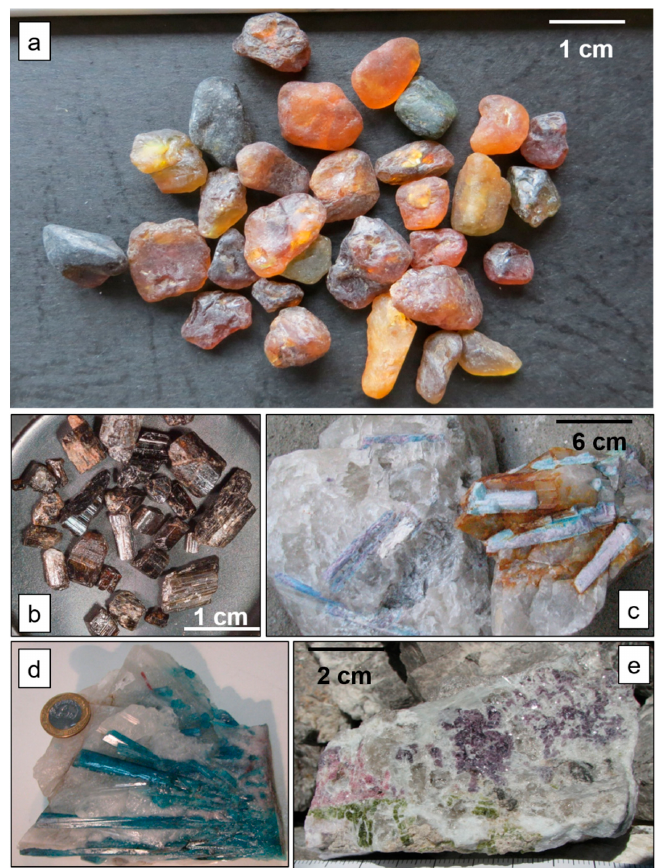
Figure 10. Tourmaline s.s.s. from placer and pegmatite deposits. ( a ) Panned concentrate for subrounded tourmaline from a fluvial placer in Tanzania. ( b ) Tourmaline concentrate from a colluvial placer SE Germany. ( c ) Pink and blue elbaite tourmaline laths in the Batalha Pegmatite, Brazil. ( d ) Paraiba tourmaline from the Capoeira Pegmatite, Brazil. ( e ) Pink and blue and elbaite and green verdellite from the Mendoza Pegmatite Province, Argentina.